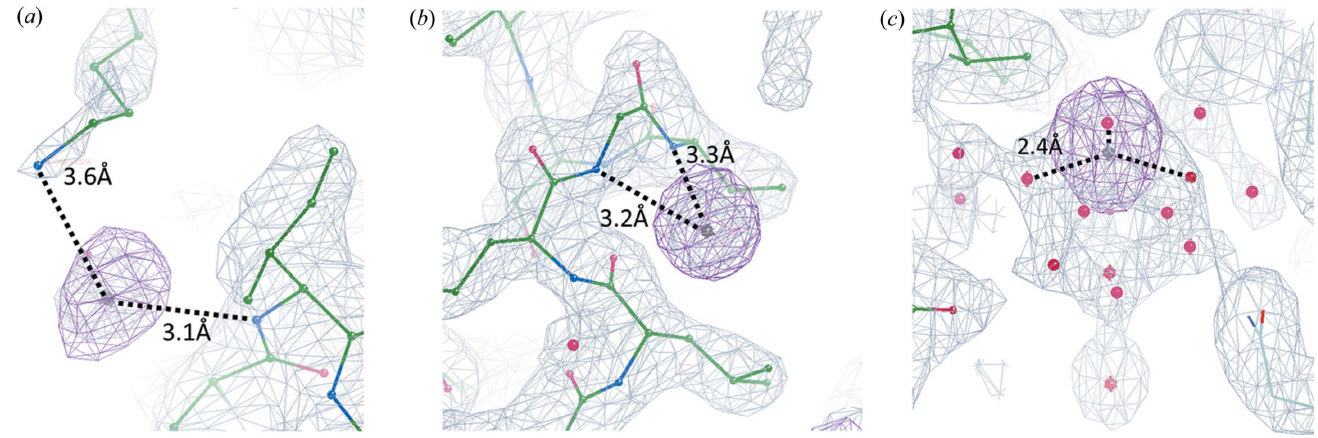
Figure 7 Electron densities for three non-sulfur anomalous scatterers in TehA. 2 F o (cid:4) F c electron densities are shown as gray isomeshes at 1.5 (cid:3) ; and Bijvoet- difference Fourier peaks are shown as purple isomeshes at 4.0 (cid:3) . The refined TehA model is shown as sticks. ( a ) Peak 9. ( b ) Peak 10. ( c ) Peak